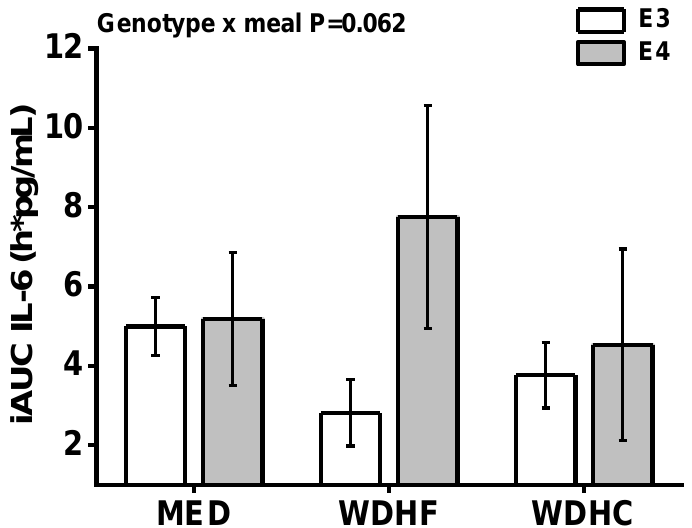
Figure 3. Effects of the APOE genotype (E3 vs. E4) on postprandial changes in plasma IL-6 levels in high CVD risk individuals after the consumption of three different meals, as indicated by incremental AUC (iAUC) values. Data are represented as the mean ± SEM. Genotype × meal interaction, p = 0.062. MED, Mediterranean-like diet meal; WDHC, Western-like diet high-carbohydrate meal; WDHF, Western-like diet high-fat meal.